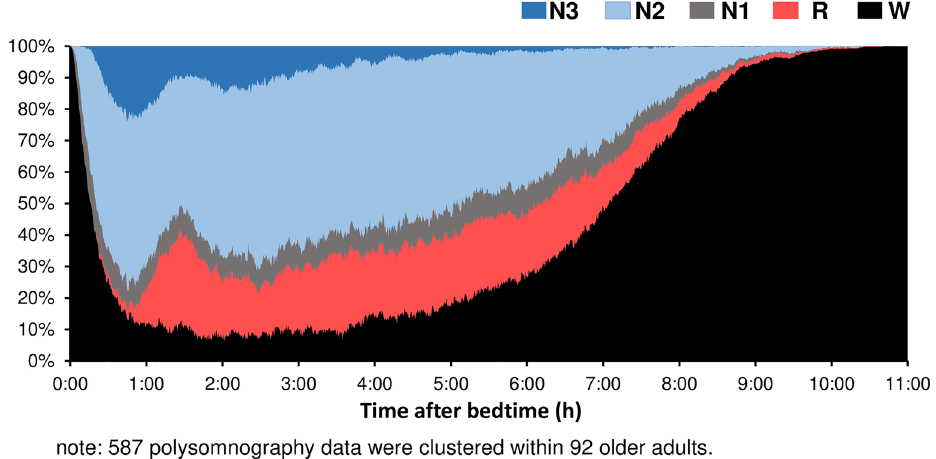
Figure 1. Cumulative display of sleep architecture in all 92 participants. The percentage of participants in each sleep stage is shown for stages W (black), N1 (gray), N2 (light blue), N3 (blue), and R (red). W awake, R